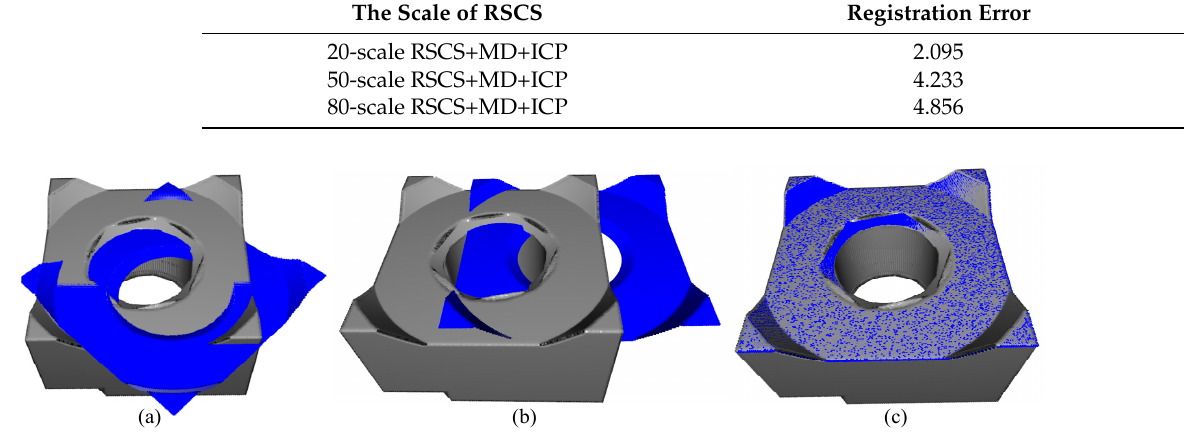
Figure 14. Registration results of RSCS at different scales. ( a ) Scale of 20; ( b ) Scale of 50; ( c ) Scale of 80.